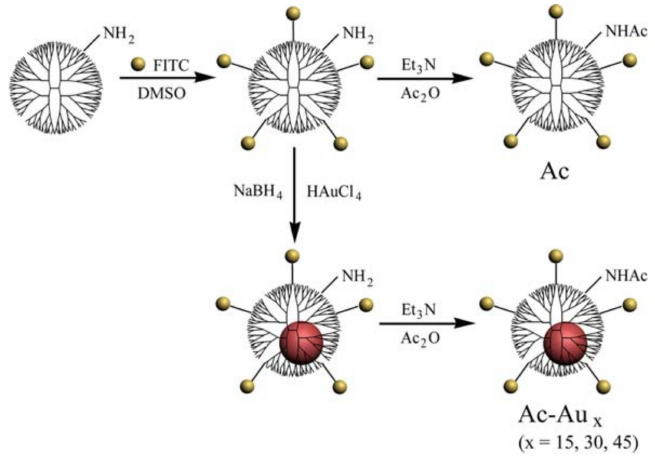
Figure 1. Schematic illustration of the synthesis of Ac and Ac-Au x